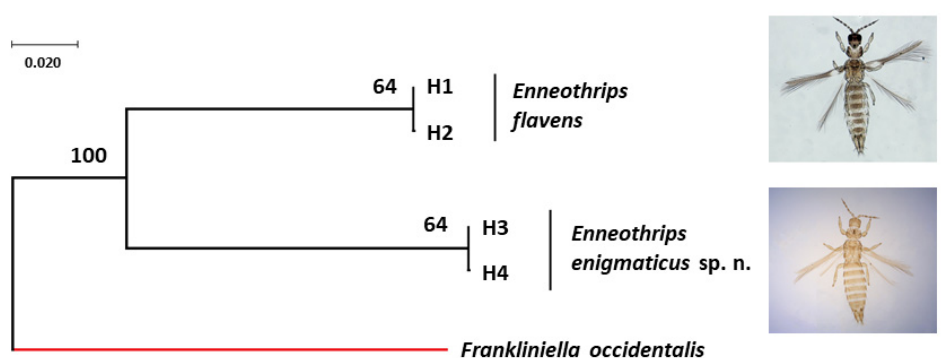
Figure 5. Bayesian tree of Enneothrips flavens and Enneothrips enigmaticus sp. n. haplotypes with posteriori probability values for each node/branch based on cytochrome c oxidase subunit I ( COI ) gene fragment sequences. The COI sequence of Frankliniella occidentalis (NCBI accession number: HQ930545) was used as the outgroup.